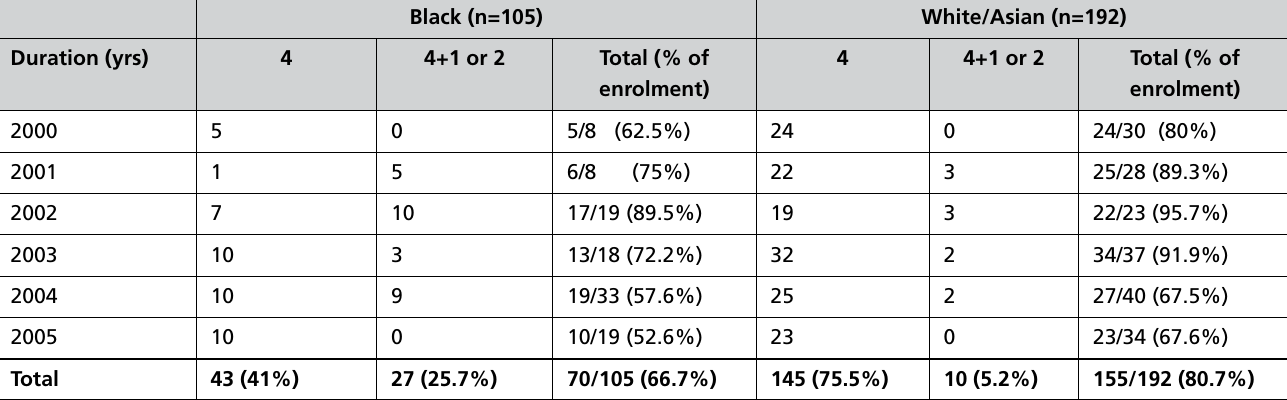
Table 4: Racial profile of students who successfully completed the program (n=225)